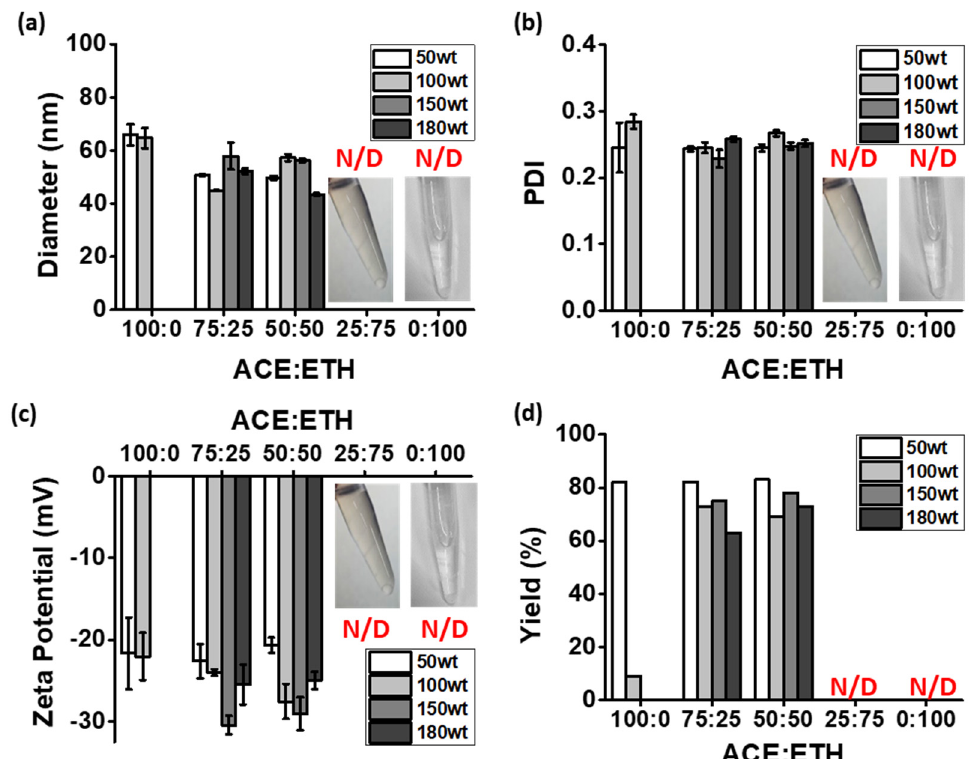
Figure 3. Physicochemical properties of PTX@TNPs prepared by using the co − solvent acetone(ACE)/ethanol(ETH) at various ratios. ( a ) Hydrodynamic diameter, ( b ) polydispersity index (PDI), ( c ) zeta potential, and ( d ) production yield (mean ± SD, n = 3; N/D, non–detection).